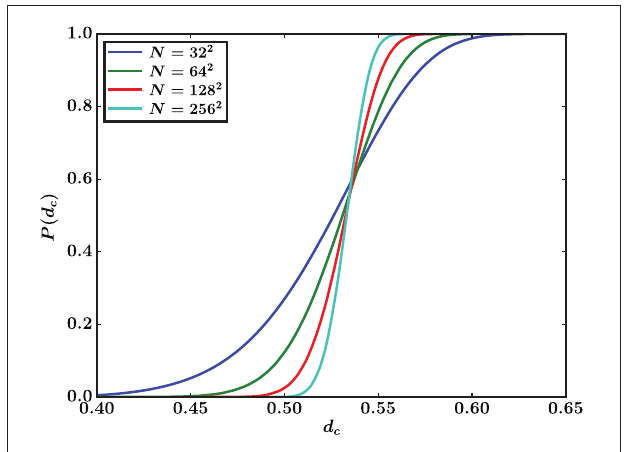
FIGURE 6 | Cumulative distribution of critical strength P ( σ c ) for LLS on a square lattice. The number of samples is 8 × 10 5 , 2 × 10 5 , 10 5 , and 3 × 10 4 for system sizes N = 32 2 , 64 2 , 128 2 , and 256 2 , respectively. The threshold distribution is uniform: P ( t ) = t .